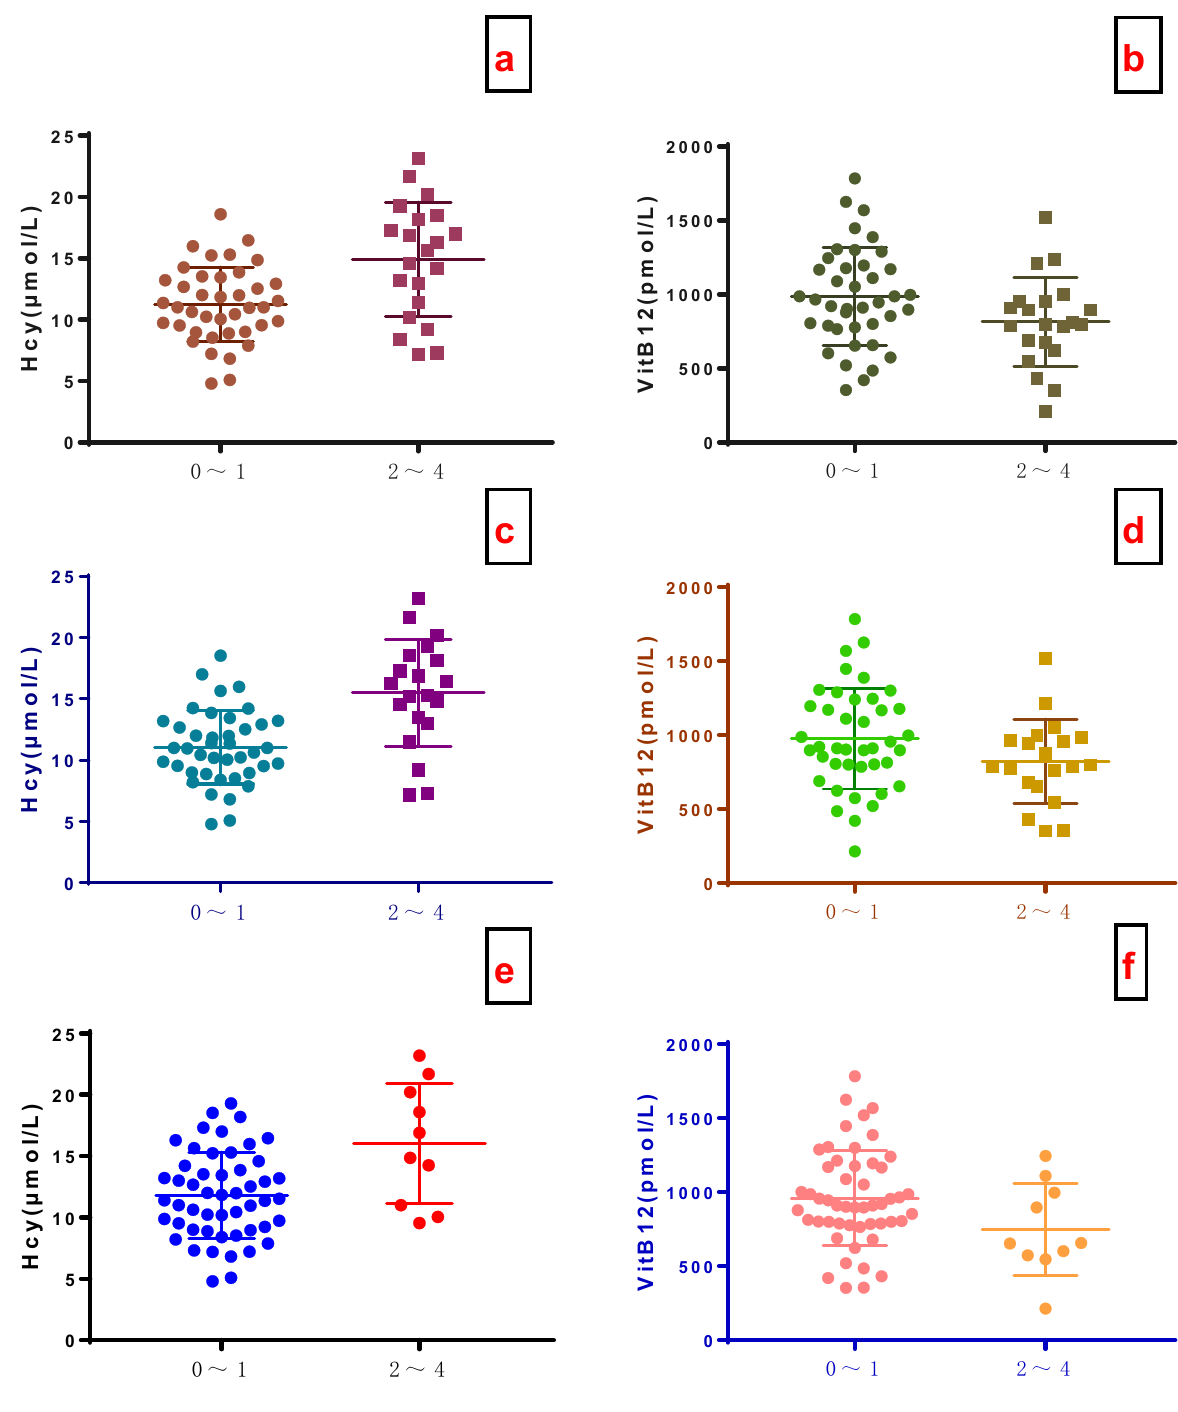
Figure 1: Serum Hcy and VitB12 distribution for each haematological toxicity group. Serum Hcy distribution in grade 0-1 and 2-4 leucopenia(a), neutropenia(c) and thrombocytopenia(e). Serum VitB12 distribution in grade 0-1 and 2-4 leucopenia(b), neutropenia(d) and